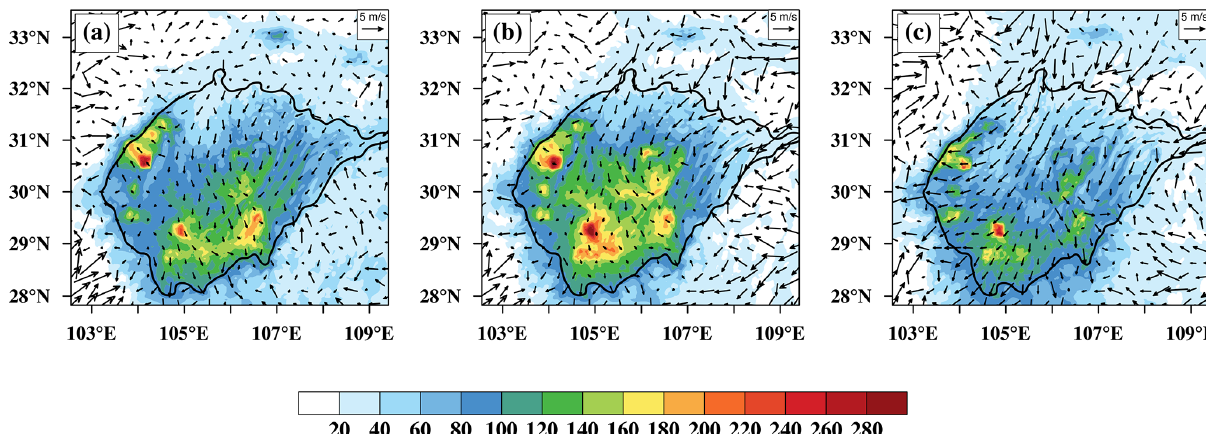
Figure 7. Horizontal distribution of surface PM 2 . 5 concentrations (µgm − 3 ; color contours) and wind vectors at 10m averaged in the periods